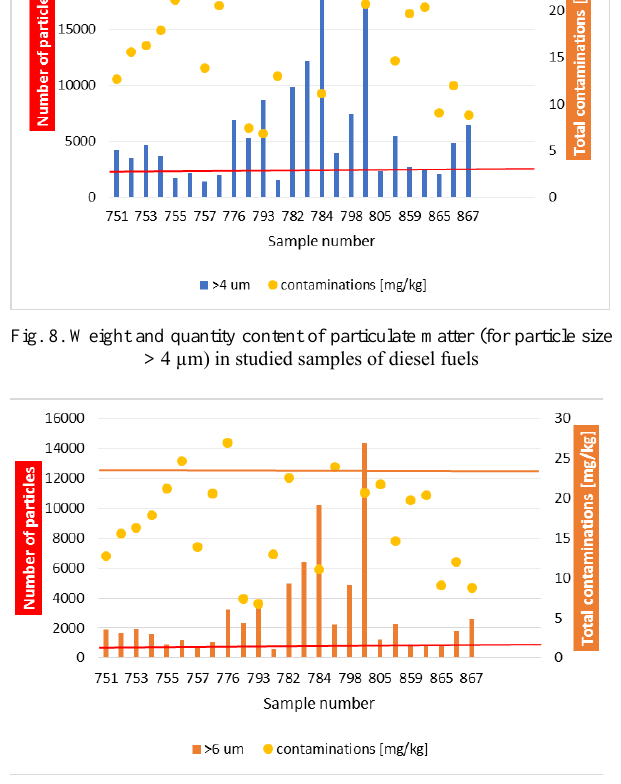
Fig. 9. Weight and quantity content of particulate matter (for particle size > 6 µm) in studied samples of diesel fuels